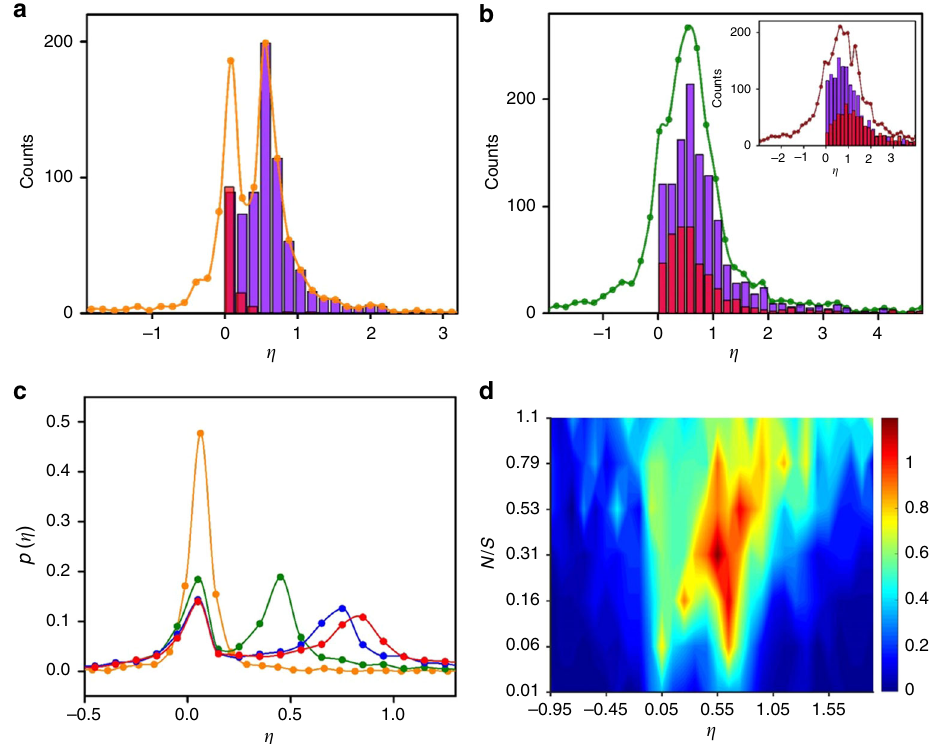
Fig. 5 Measurement of ef fi ciency fl uctuations. a , b Histograms of the experimentally measured ef fi ciency η = – β W / I for τ = 3 ms and N / S = 0.06 (orange), 0.32 (olive) and 0.79 (wine in inset of b ). The solid curves are guides to the eyes. The violet (red) bars correspond to β W < 0( β W > 0) and I > 0 ( I < 0), respectively. c Ef fi ciency distribution (from simulation) for N / S = 0.034 at four different cycle times τ = 0.1 (orange), 1 (olive), 3 (blue), and 10 (red) ms. d Contour plot showing the fl uctuations in ef fi ciency distribution as a function of noise level N / S for τ = 3